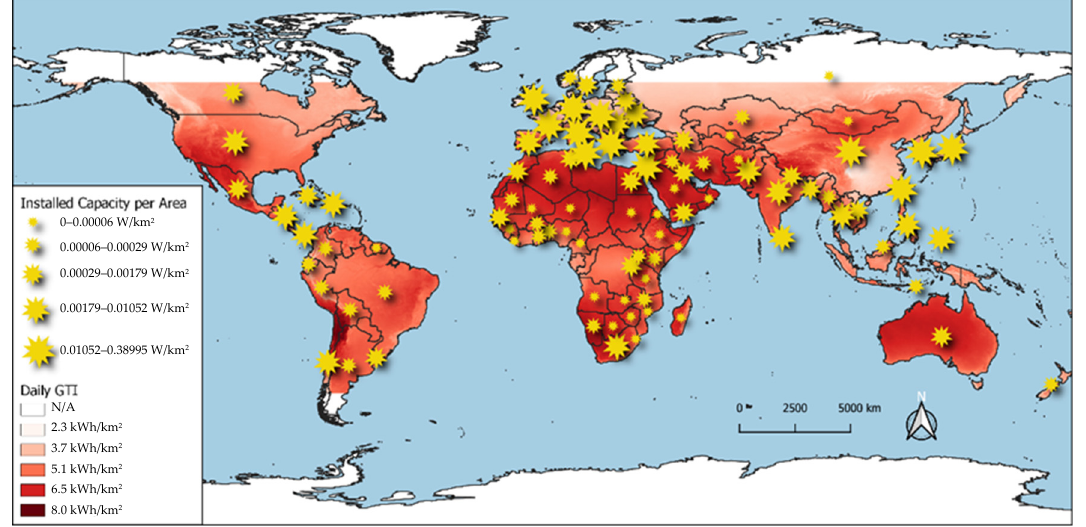
Figure 1. Daily GTI and installed capacity per country [15,16].